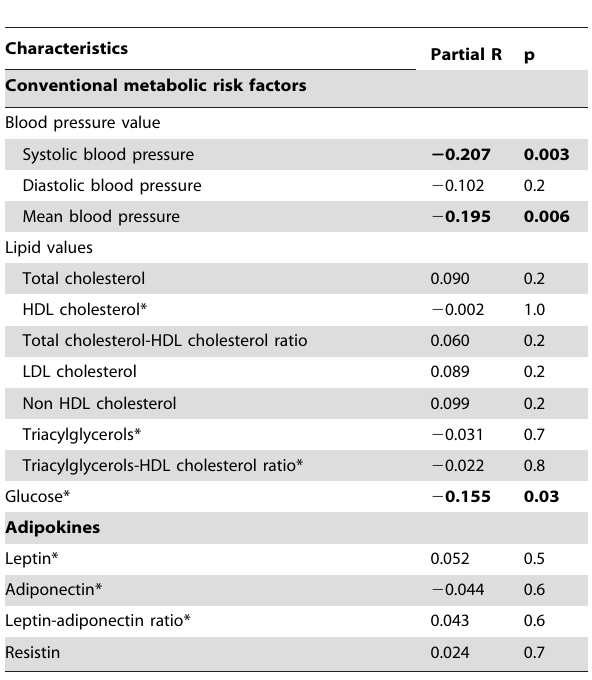
Table 3. Independent relationships of retinol binding protein 4 concentrations with metabolic risk factors.